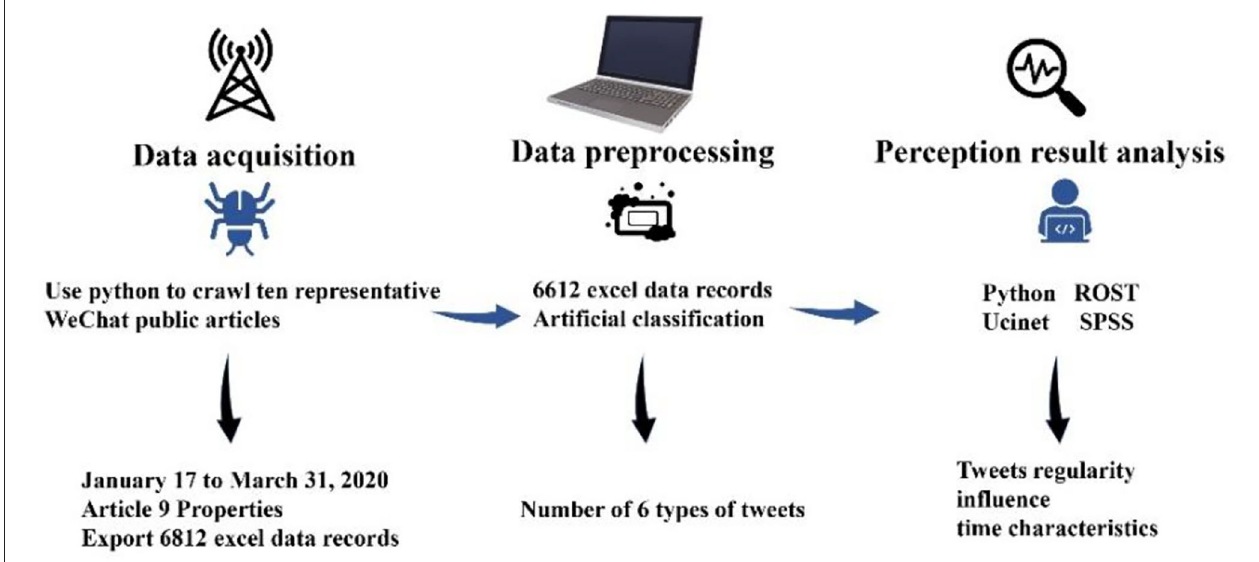
FIGURE 1 | Research framework on the characteristics of WeChat official account tweets.